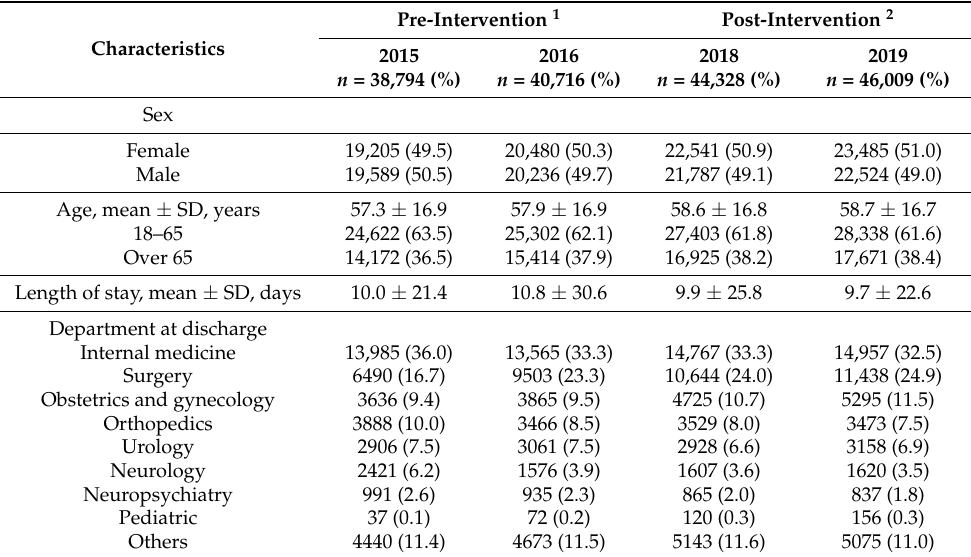
Table A1. Demographics in each pre- and post-intervention